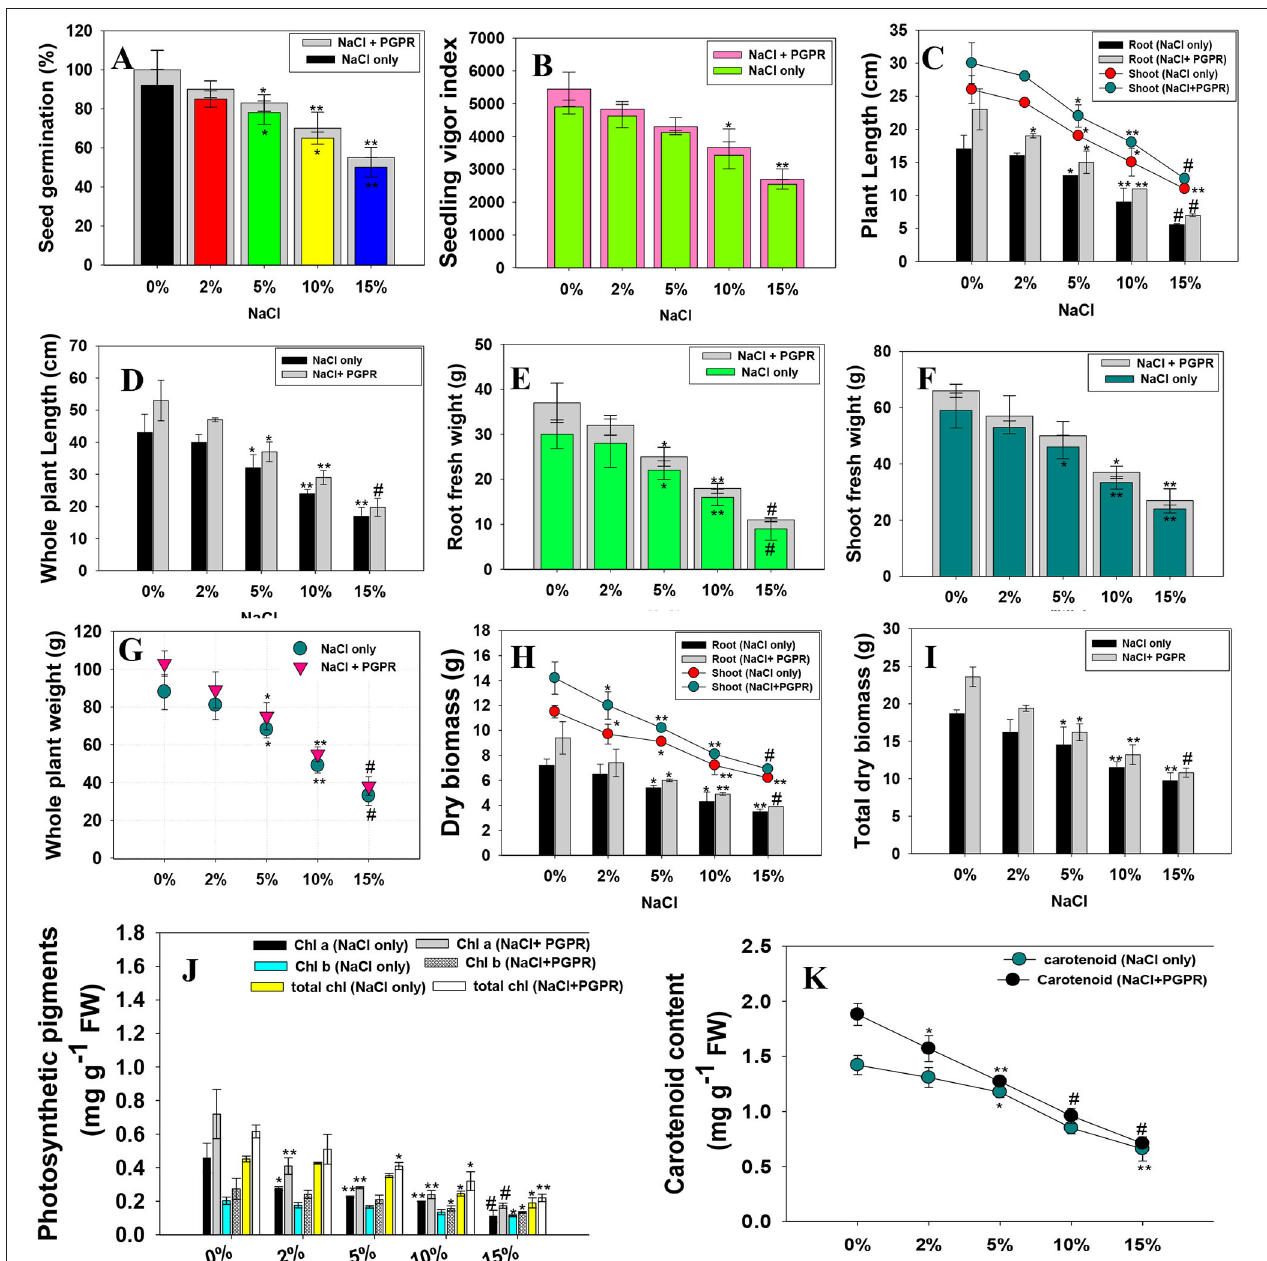
FIGURE 3 | Bio-inoculation impact of halotolerant PGPR strain on germination efficiency (A) , Vigor index (B) , Biological attributes; root shoot length (C) , Whole plant length (D) , Root (E) , Shoot fresh weight (F) , Whole plant weight (G) , Root-shoot dry biomass (H) , Total dry biomass (I) , Photosynthetic pigments (J) and carotenoid content (K) of radish plants raised in soils treated with different levels of NaCl. In this figure, the bar, and line diagrams represent the mean values of three replicates ( n = 3). Corresponding error bars represent the standard deviation (S.D) of three replicates (S.D, n = 3). The asterisks *, ** and # denote statistical significance at p < 0.05, p < 0.005 and p < 0.001, respectively computed by Student’s t -test.